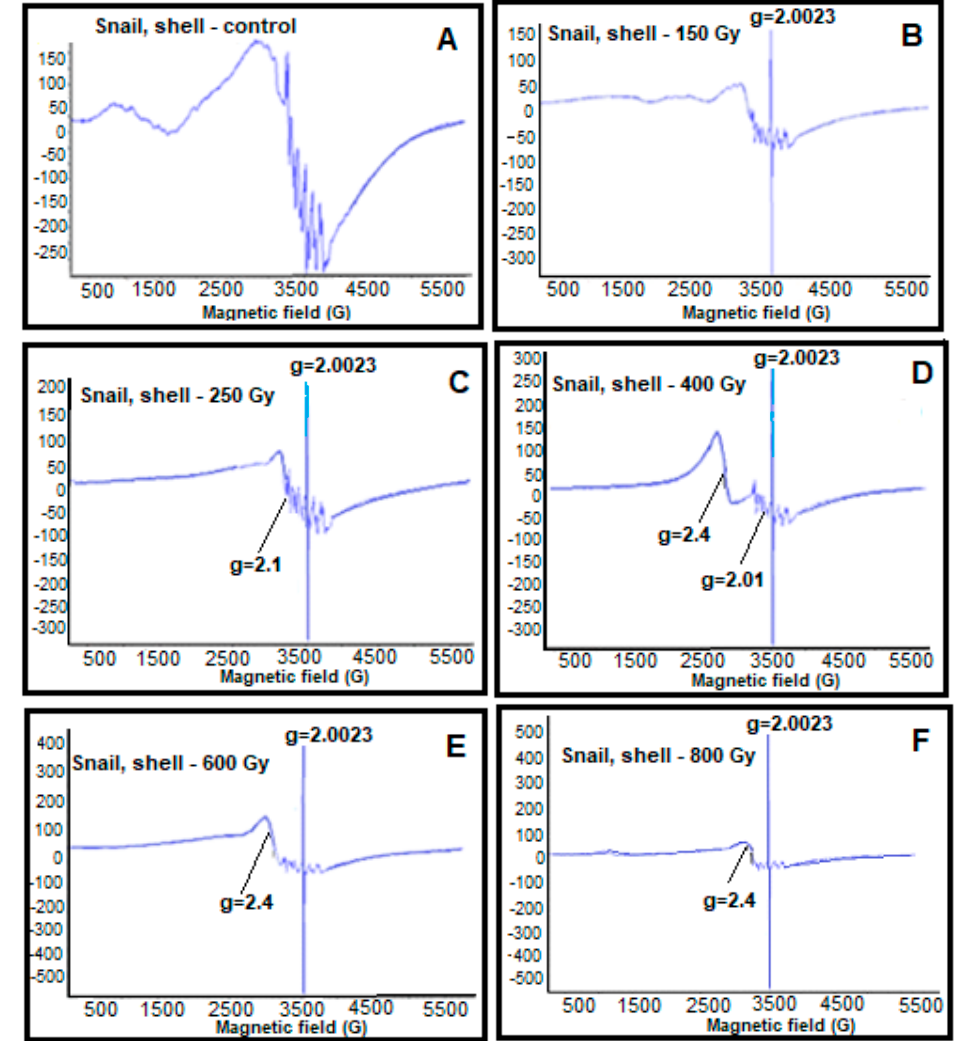
Figure 1. EPR spectra of shell parts of the control and irradiated at different doses of old snails. ( A ) control, ( B ) 150 Gy, ( C ) 250 Gy, ( D ) 400 Gy, ( E ) 600 Gy, and ( F ) 800 Gy. The parameters of the EPR spectrometer are as follows: center field—3000 G; sweep width—5500 G; resolution—1024 points; frequency—9870 GHz; power—2102 mW; modulation frequency—100 kHz; modulation amplitude—10 G.